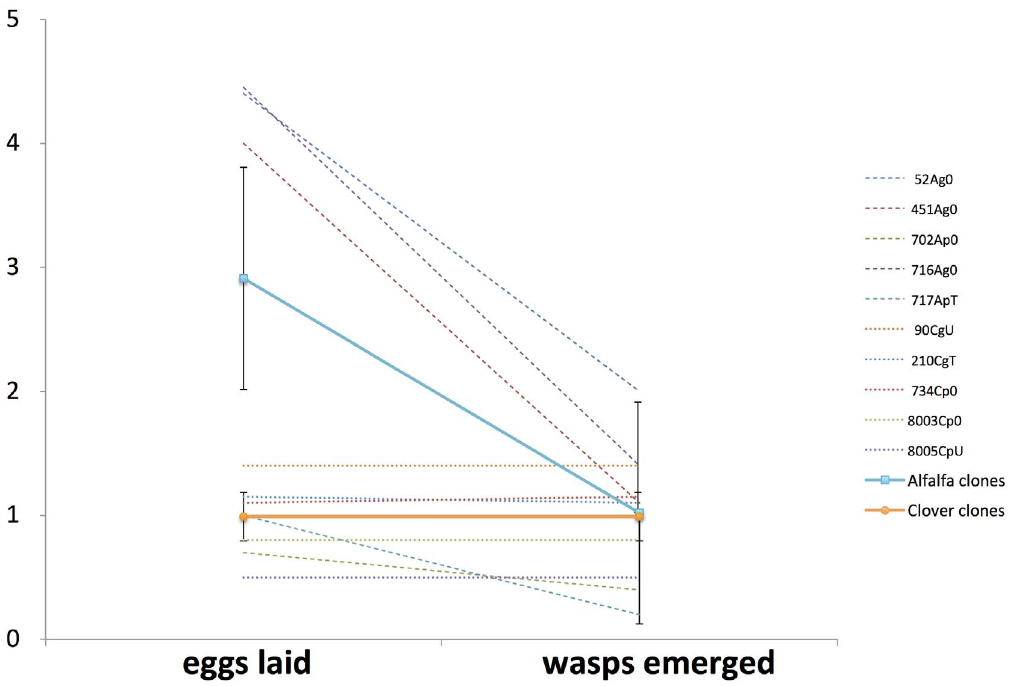
Figure 3. Different fitness trends of infecting (adult female wasp) versus exploiting (egg, larva) stages of Aphidiuservi on host aphid clones from alfalfa and clover. Adult females on average laid three eggs on alfalfa clones to produce one adult progeny, compared to one egg on clover aphid clones. The wasp progeny as freshly laid eggs are three times more likely to survive to adult emergence on clover than alfalfa hosts, indicating wasp behavioral compensation at the time of egg laying. Lines added for clarity, there is no implication of linearity in the relationships. Dotted lines are for individual clones (see Table 1), and solid lines with standard error bars represent mean trends (n=5 clones per crop plant). Letter A or C in clone name stands for the Acyrthosiphon pisum subspecies alfalfa or clover.